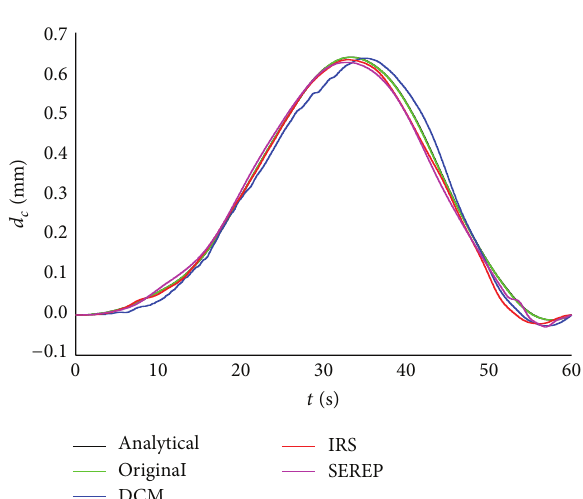
Figure7:Comparisonofdeflectionattheimpactpoint 𝑑 𝑐 calculated by the condensed models for the full FE and analytical